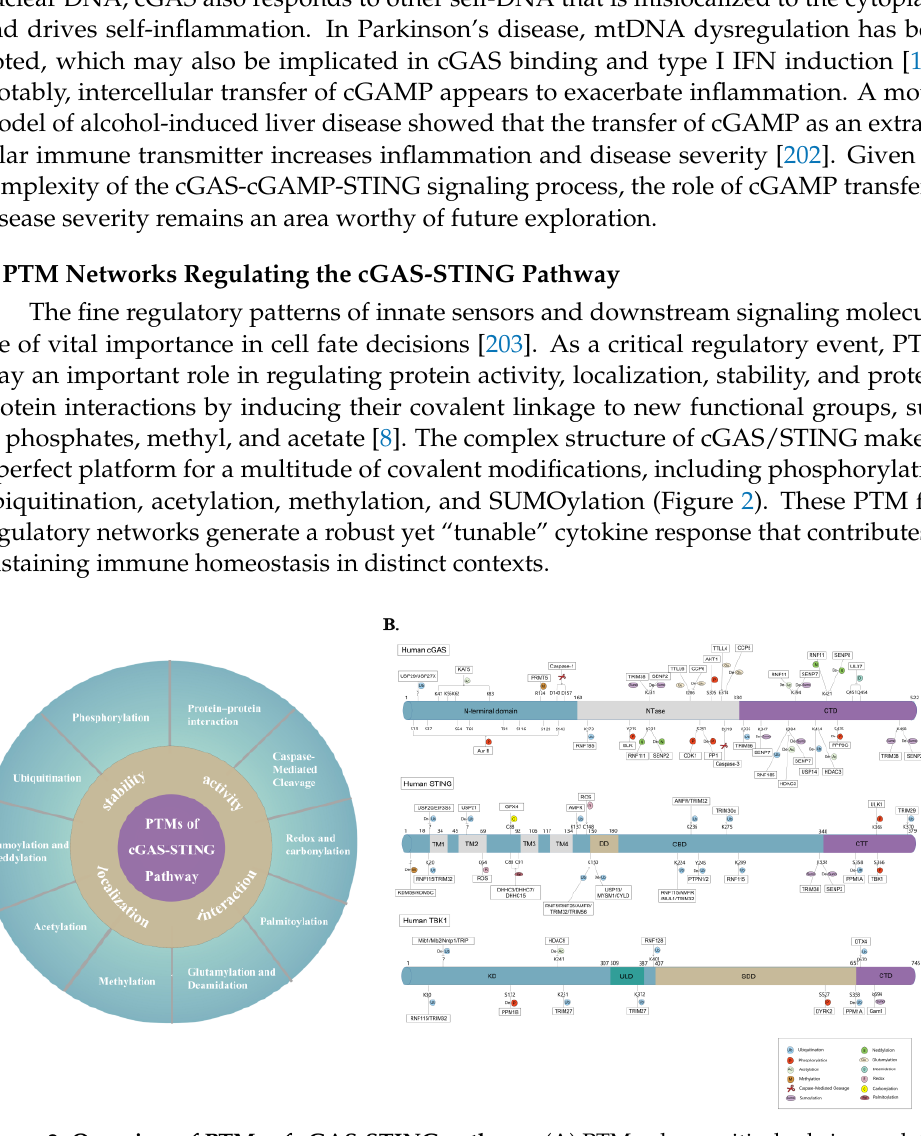
Figure 2. Overview of PTMs of cGAS-STING pathway. ( A ) PTMs play a critical role in regulating cGAS-STING pathway, including protein stability, activity, localization, and interaction. ( B ) Defined modification sites for cGAS/STING/TBK1 (ubiquitination, phosphorylation, acetylation, methylation, caspase-mediated Cleavage, sumoylation, neddylation, glutamylation, deamidation, redox, carbonylation, and palmitoylation) and their modifying enzymes are plotted. Different colors are used to differentiate distinct modification types. Abbreviations: NTase, nucleotidyl transferase; CTD, C-terminal domain; TM, transmembrane domain; DD, dimerization domain; CBD, cyclic dinucleotide-binding domain; CTT, C-terminal tail; KD, kinase domain; ULD, ubiquitin-like domain; SDD, scaffold and dimerization domain.